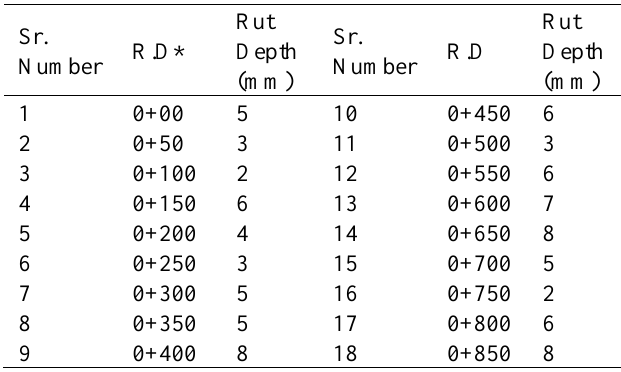
Rutting values Sr.